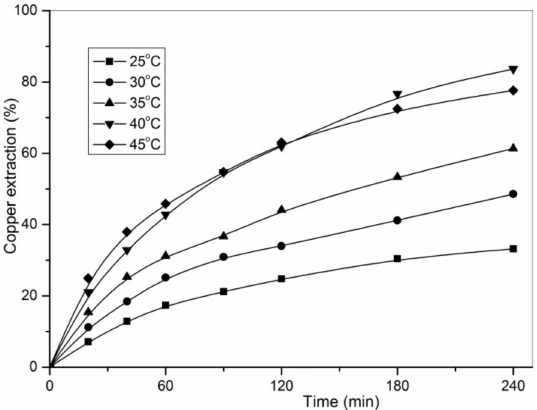
Figure 4. Influence of the temperature and time on the copper extraction yield (particle size − 37 µ m, stirring speed—100 rpm, solid / liquid ratio—2 g / dm 3 , 1.5 M H 2 SO 4 , 1 M H 2 O 2 ).